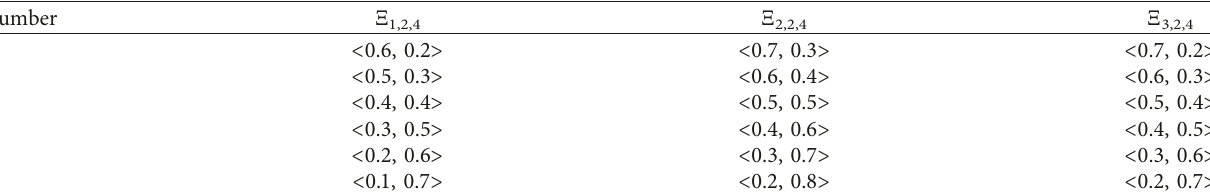
� 1, 2, 3) in M k ,2,4 ( k